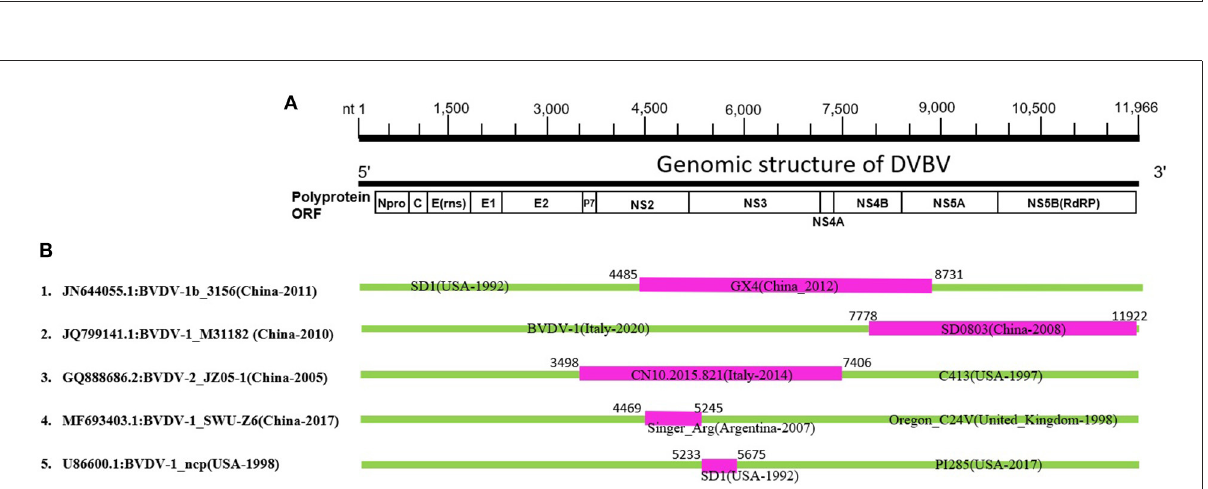
FIGURE3 Genetic recombination analysis of 143 full-length BVDV genomes. (A) Diagram showing the full-length genome of BVDV and the corresponding regions encoding Npro, C, Erns, E1, E2, P7, NS2, NS3, NS4A, NS4B, NS5A, and NS5B. The numbers indicate the nucleotide positions relative to the genome of BVDV-1 (GenBank ID: JQ799141.1, China-2010). (B) Schematic representation of the five potential recombination events listed in Table 1. The recombination event serial number and the description of potential recombinants (GenBank ID: virus name/country-collection year) are show on the left. The filled pink and green blocks represent the DNA regions from minor and major parent viruses, respectively. The numbers on the top of filled green blocks indicate the nucleotide positions of breakpoints relative to the genome sequence of corresponding recombinant viruses on the